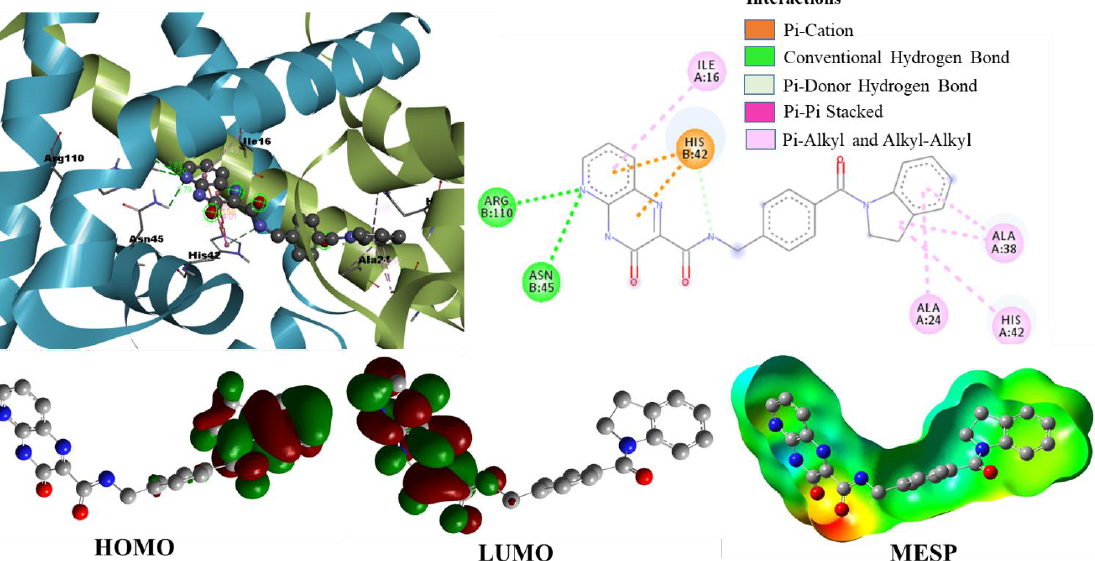
Figure 6. Binding mode conformation and molecular interactions of ZINC77906236 in the active site of S. epidermidis TcaR. The left and right figures represent the molecular interactions in 3D and 2D, respectively. The hit compound is shown in the ball-stick model, and the key interacting residues are shown as grey sticks. Isodensity plots of HOMO and LUMO and molecular electrostatic potential of hit compound.